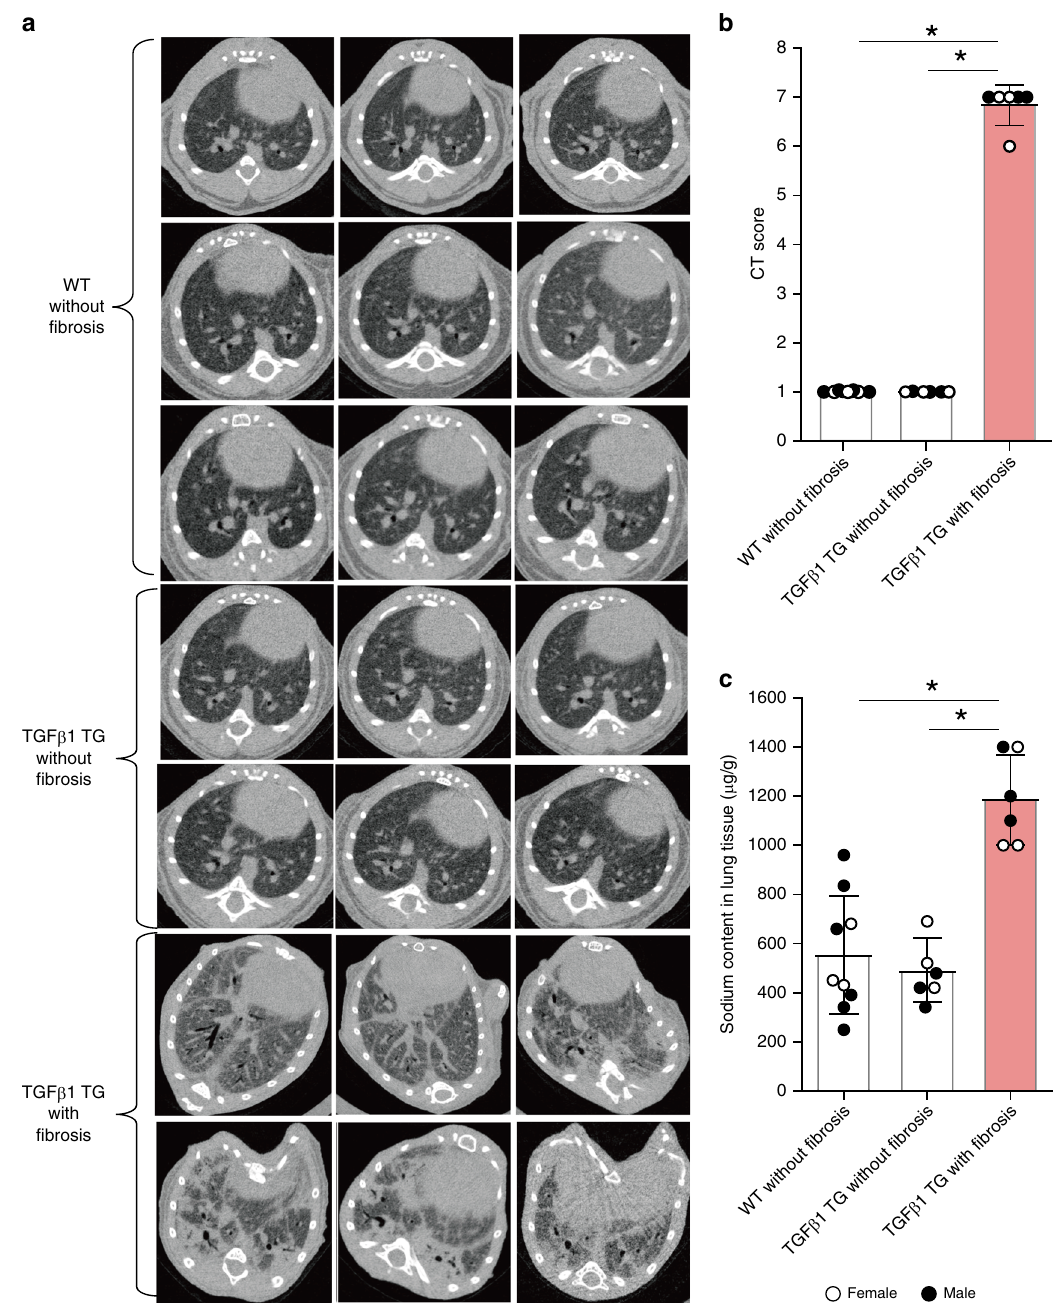
Fig. 1 The fi brotic lung tissue is a salty microenvironment. a , b Chest computed tomography (CT) fi ndings and CT scores of wild-type and TGF β 1 transgenic (TG) mice. n = 9 in WT without fi brosis, n = 6 in TGF β 1 TG without fi brosis and TGF β 1 TG with fi brosis. Bars indicate the means ± S.D. Statistical analysis by ANOVA with Tukey ’ s test. * p < 0.001. c The lung tissue Na + was measured by microwave analysis/inductively coupled plasma mass spectrometry. Fibrotic lung tissues excised from wild-type and transforming growth factor (TGF) β 1 TG mice with and without ( n = 6) lung fi brosis. n = 9 in WT without fi brosis, n = 6 in TGF β 1 TG without fi brosis and TGF β 1 TG with fi brosis. Bars indicate the means ± S.D. Statistical analysis by Mann – Whitney U test. Statistical analysis by ANOVA with Tukey ’ s test. * p < 0.001. The source data underlying Fig. 1b, c are provided in the Source Data fi